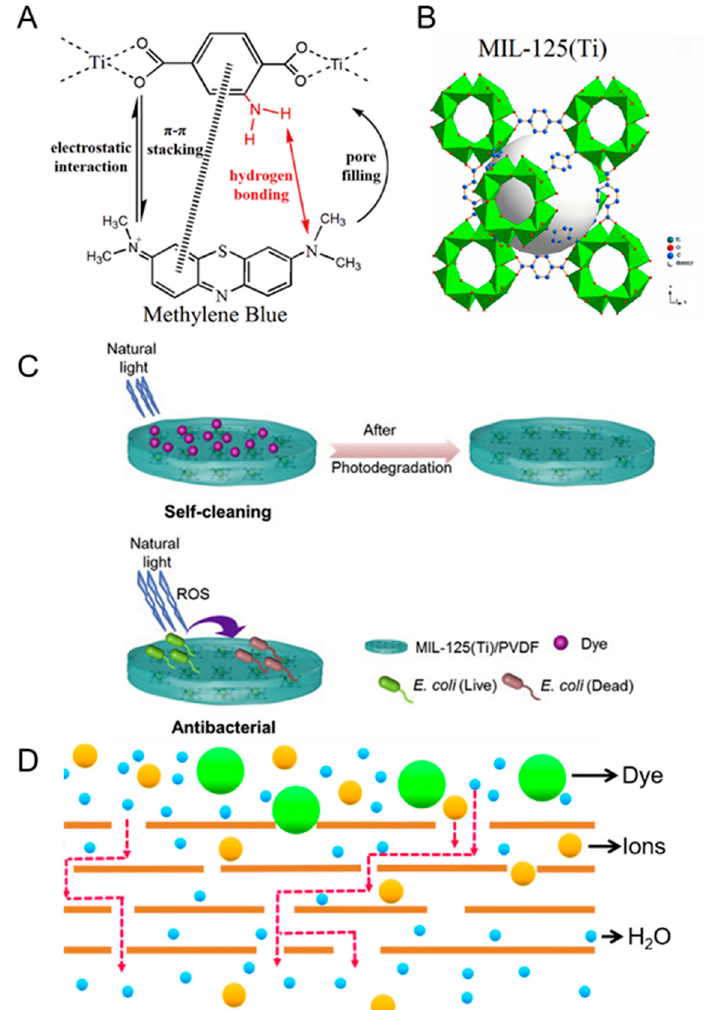
Figure 4. ( A ) Schematic illustration of the three possible mechanisms of methylene blue due to adsorption on Ti-MOFs: electrostatic interaction, π - π stacking interactions between the adjacent benzene rings, and hydrogen bonding [58]. ( B ) The structure of MOF MIL-125(Ti) [58]. ( C ) The illustration of the self-cleaning and anti-bacterial properties of a PVDF MMM incorporated with MIL-125(Ti) filler materials [54]. ( D ) Transport pathways of molecules with various hydrated sizes through graphene oxide sheets, modified from [59]. All figures are reprinted with copyright permissions from the respective references.